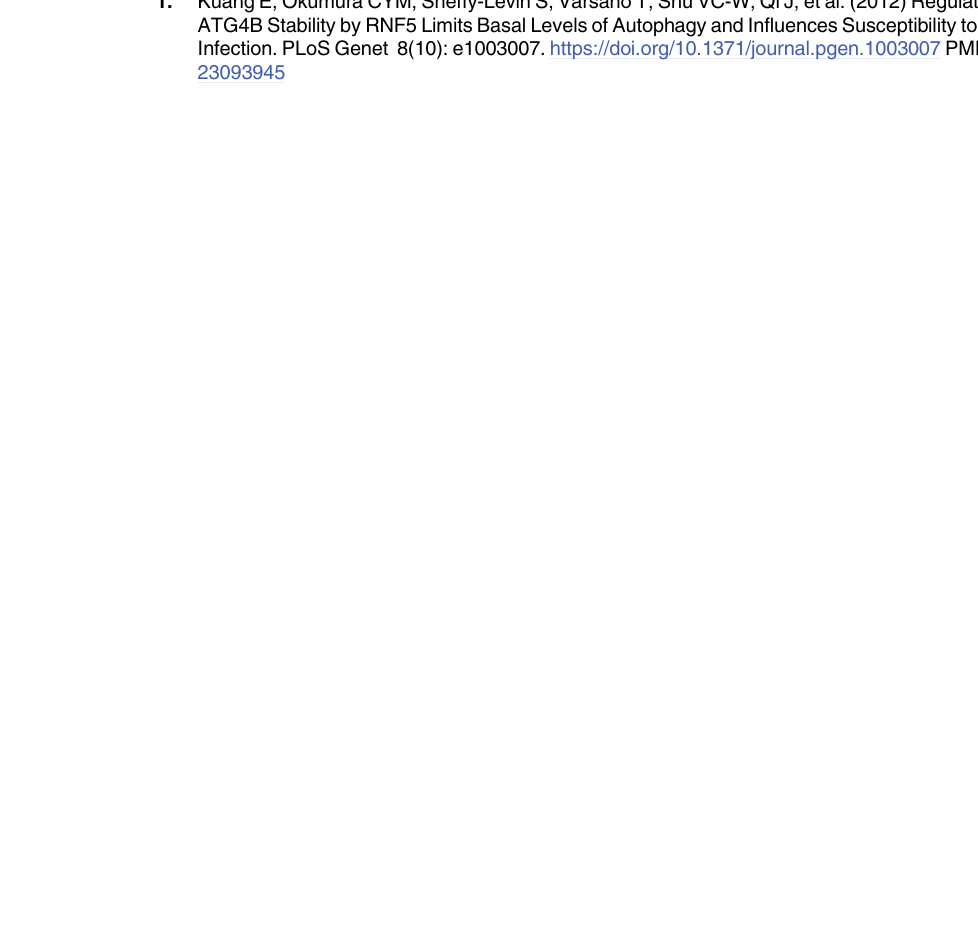
S3 File. Replicate data supporting results in Fig 4B.